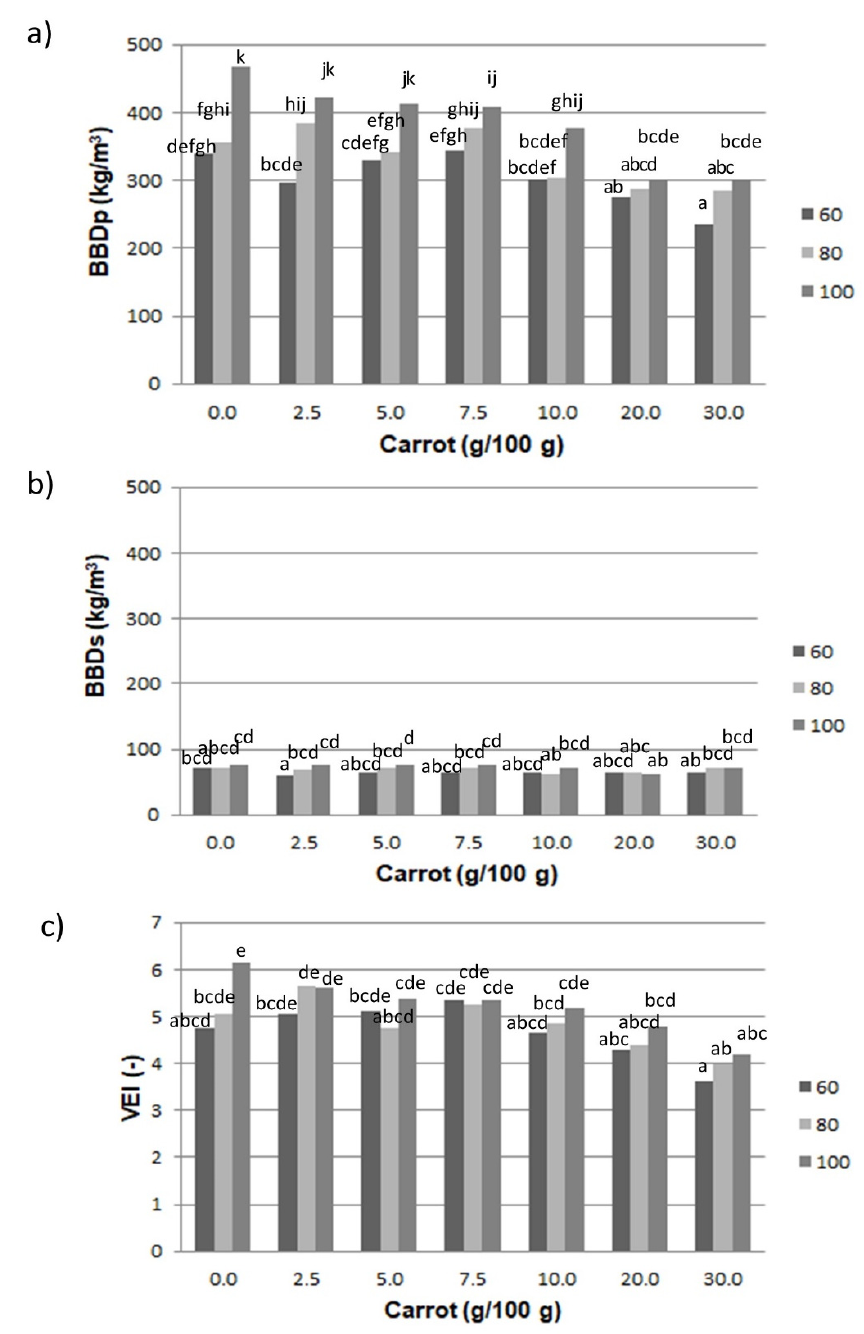
Figure 2. Results of the physical properties of extrudates supplemented with fresh carrot pulp, processed at variable screw speeds: ( a ) the bulk density of pellets, ( b ) the bulk density of snacks, ( c ) volumetric expansion index of snacks. a–k —means indicated with similar letters in each figure do not differ significantly at α = 0.05.